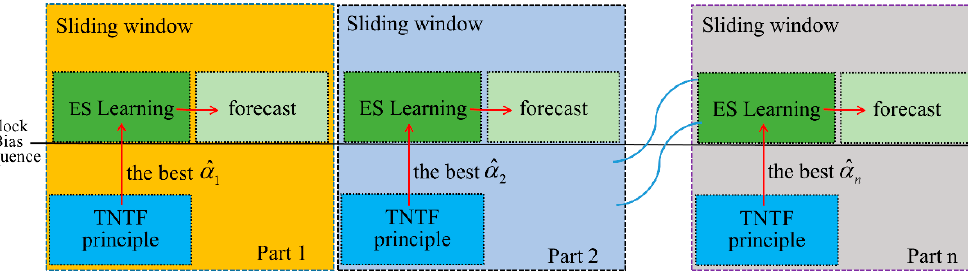
Figure 3. Flow chart of exponential smoothing (ES) clock bias prediction using a sliding window.